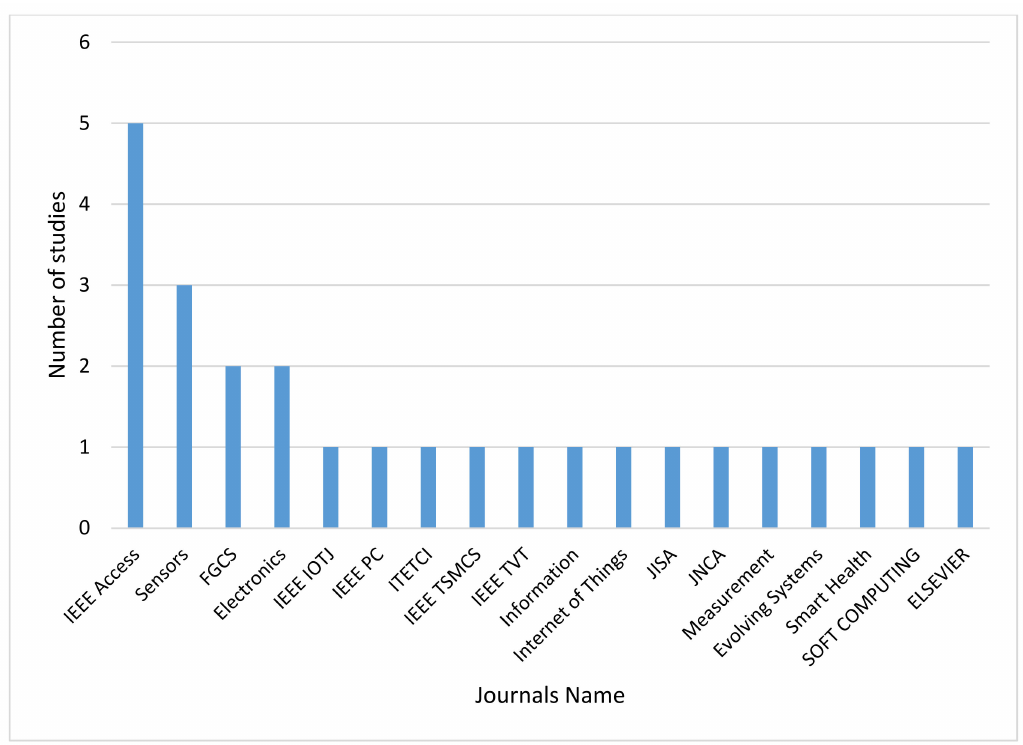
Figure 4. Selected distribution studies by